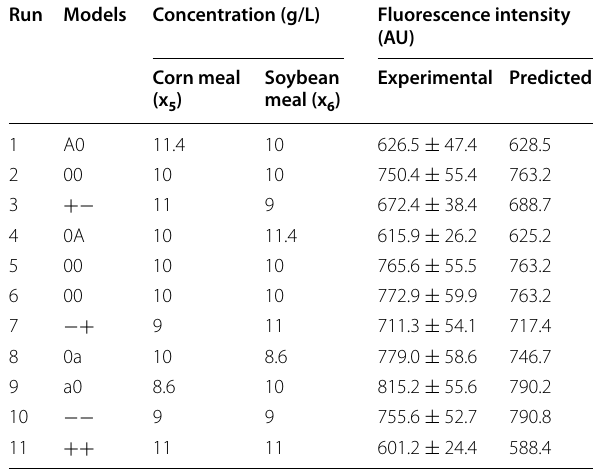
The experimental results are the means of two replicates of 1000-fold diluted spore samples. The symbols in the model column mean each factor at five different levels ( a, , 0, , A). The variables at a central coded value are − − + considered at